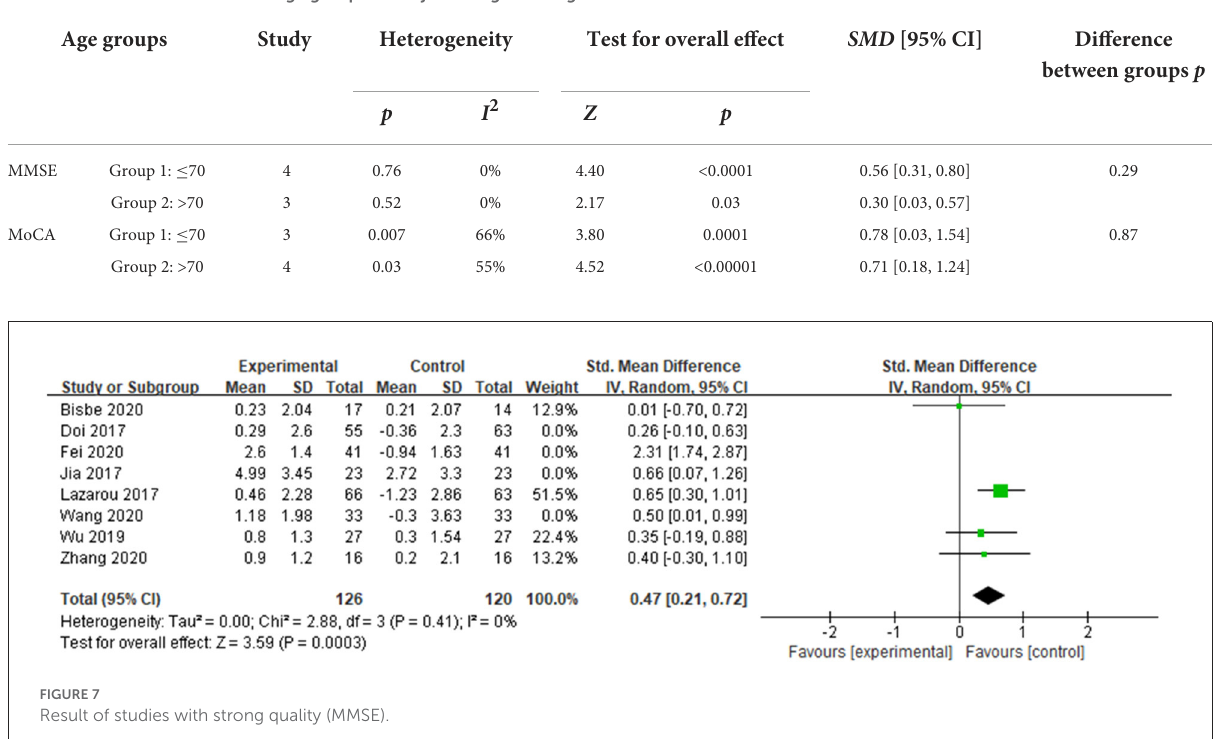
TABLE 6 The effects of different age groups of subjects on global cognition.